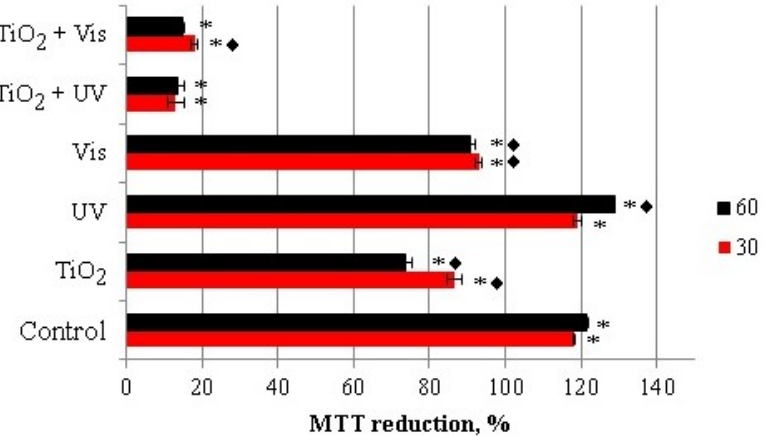
Figure 2. MTT reduction in S. Typhimurium cells. The experiments were performed at 37 °C in PBS buffer, pH 7.4, containing 0.1% glucose. The cell concentration was 3 × 10 7 cfu/mL. TiO 2 was added to 0.3 mg/L. Duration of the treatment was 30 min and 60 min. * and ♦ mark experimental values which are significantly different from the control sample and other samples respectively (more de- tails on statistical analysis are provided in Section 4.5). on statistical analysis are provided in Section